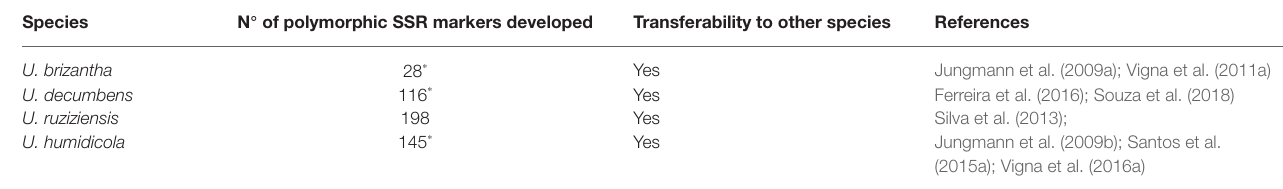
TABLE 4 | Microsatellite markers developed for Urochloa species.